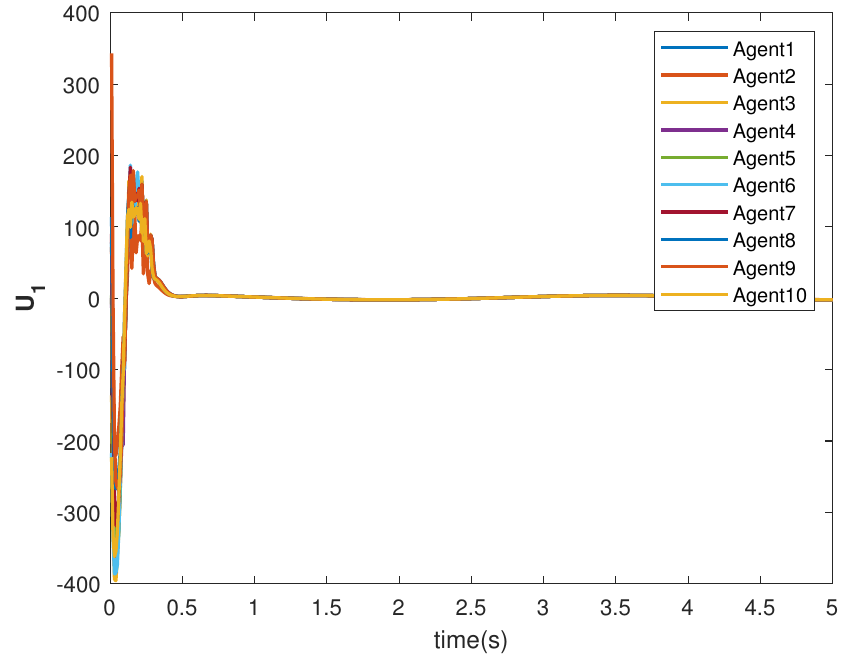
Figure 1. Control U 1 of